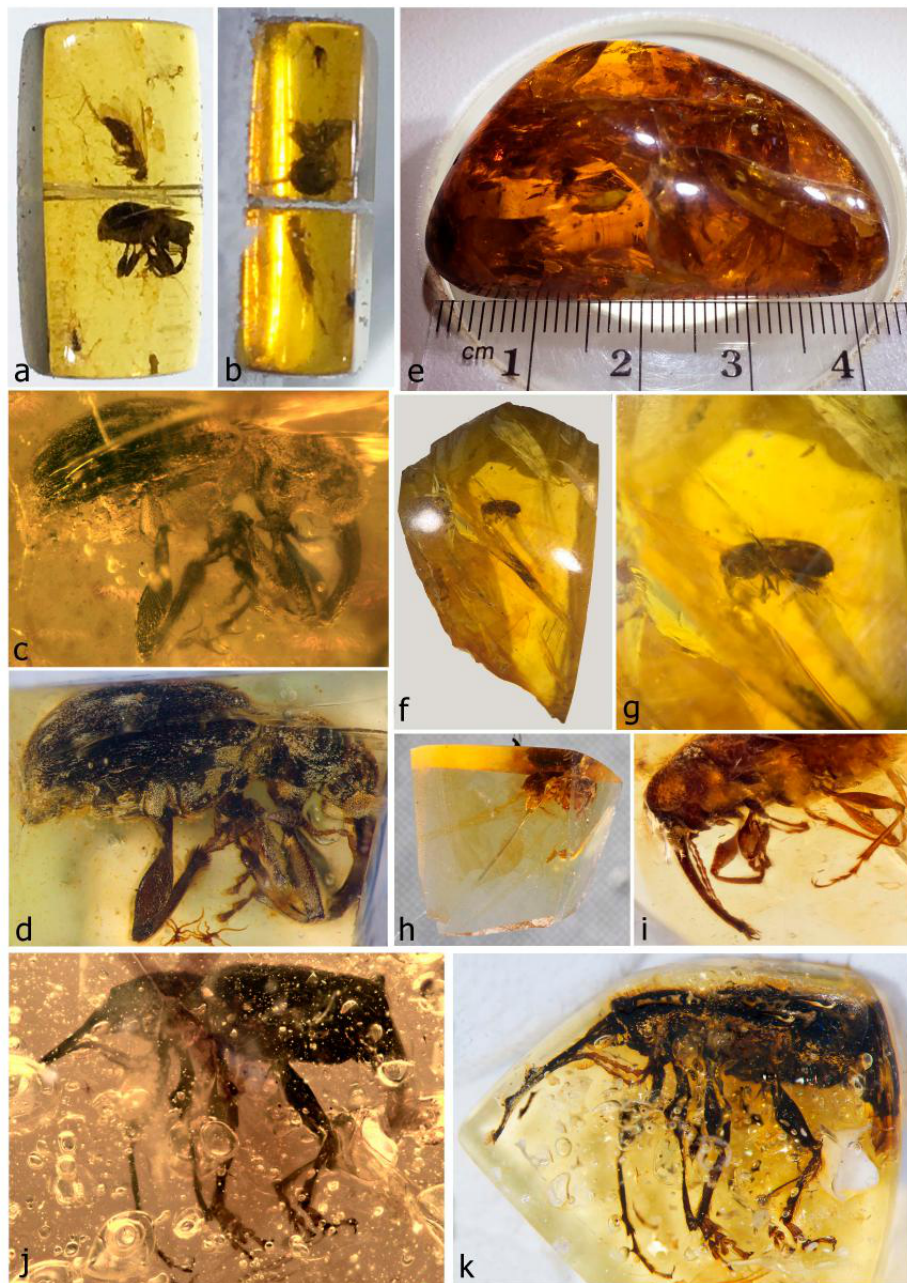
Figure 2. Block trimming to reveal inclusions in amber blocks and remove obstructions obscuring inclusions. Amber block containing holotype of Compsopsaros reneae showing sawcut between specimen and a second inclusion obscuring dorsal side ( a ); same, caudal view ( b ); same, lateral view of specimen prior to trimming ( c ); same, lateral view of specimen after removing most amber from side ( d ); original large amber piece containing holotype of Burmonyx zigrasi ( e ); resulting wedge containing specimen cut out of block, prior to final trimming ( f ); detail of specimen ( g ); final trimmed block ( h ); close-up of specimen in final block ( i ); amber piece containing holotype of Cyrtocis gibbus prior to trimming ( j ); block after trimming with specimen now largely free of bubbles and cracks ( k ).